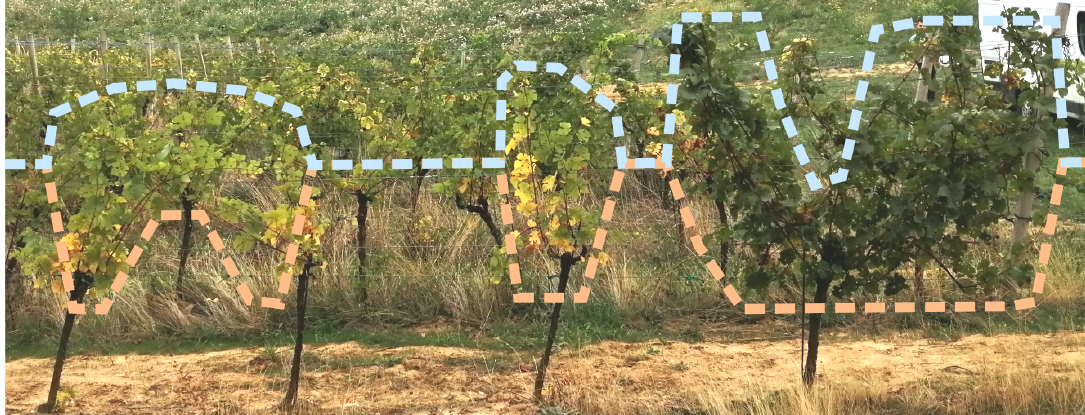
Figure 9. The canopy description used for the experiment selected by the